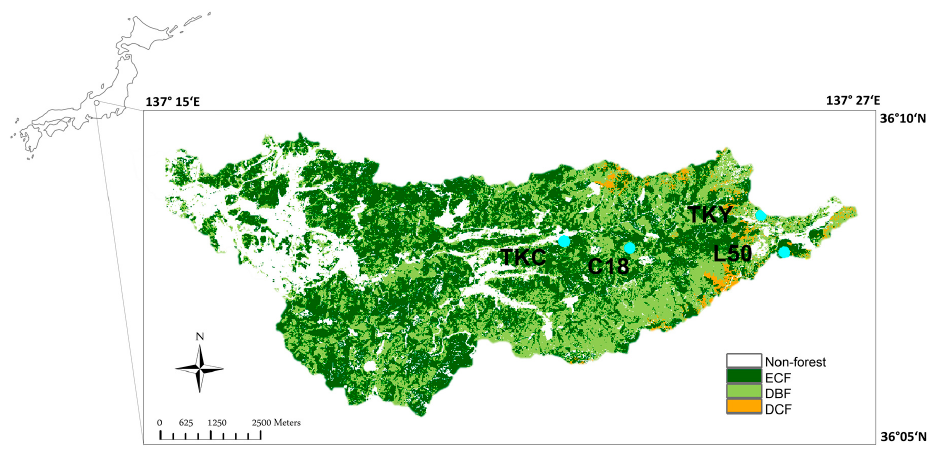
Figure 1. Forest types in the Daihachiga river basin by Fukuda et al., 2012 [33] with a 2-m spatial resolution, and the location of the four study plots.